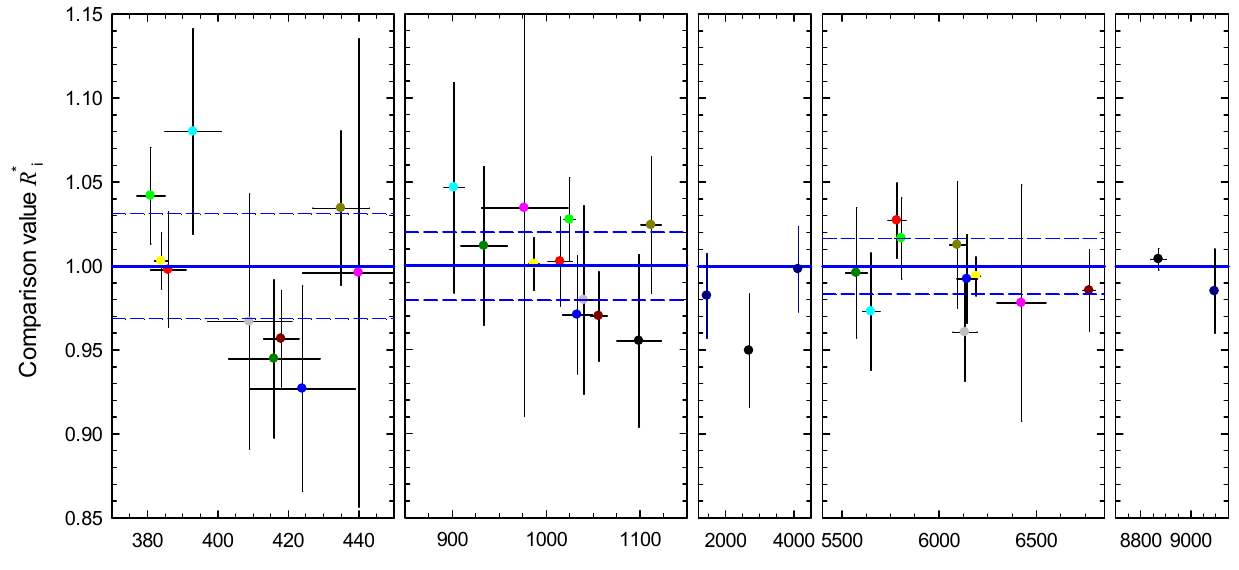
Figure 2. Comparison values given as modified ratios ( 𝑅 (cid:3036)∗ ) and attributed uncertainties; blue straight lines represent a common mean of 1, dashed blue lines cover the standard variation interval (coverage factor 𝑘 = 1 ) according to Table 5, error bars indicate the standard uncertainties of the reported values, the results of the same participant are indicated by the same color and the color assigned to the respective participant is the same as in Figure 1. Table 5. Standard and expanded variation intervals for the measurement of the radon activity concentration at different exposure levels.